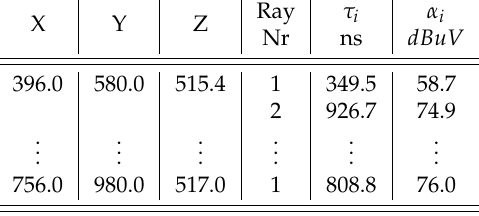
Figure 18. RT simulation